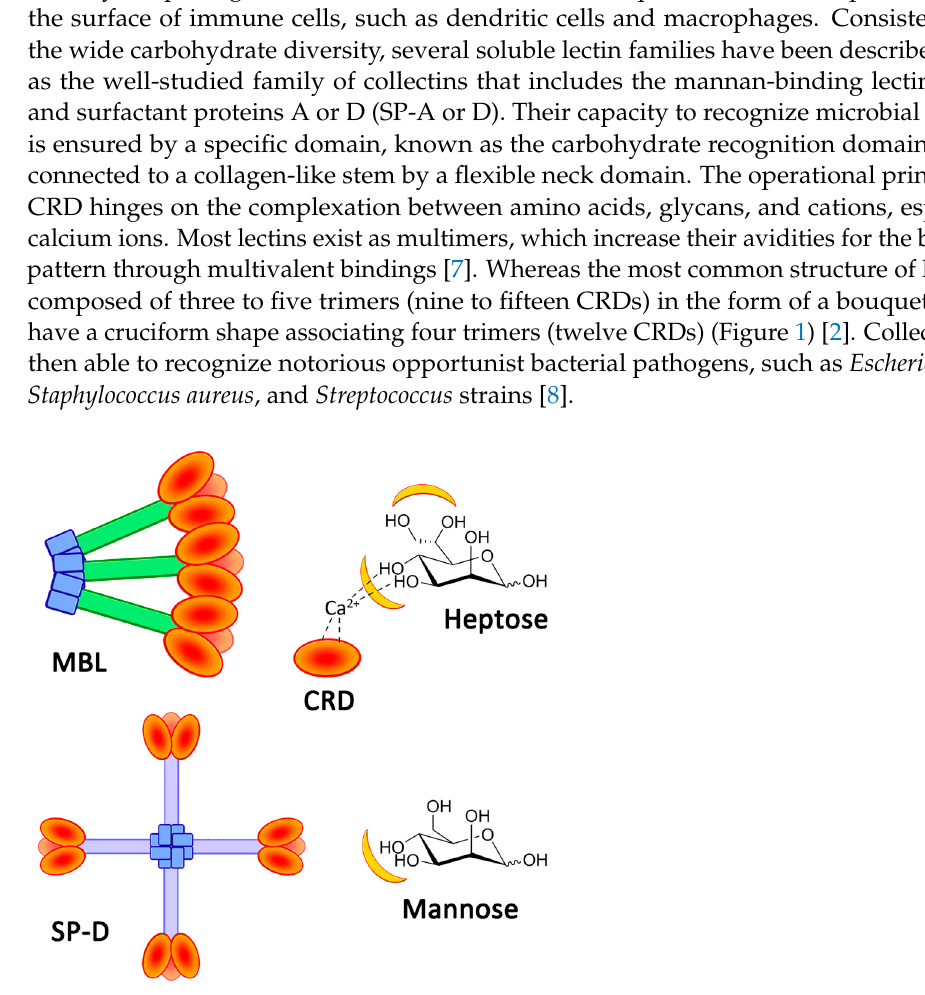
Figure 1. Representation of MBL and SP-D. The chemical structures of heptose and mannose, with lectin-recognized sites in yellow .